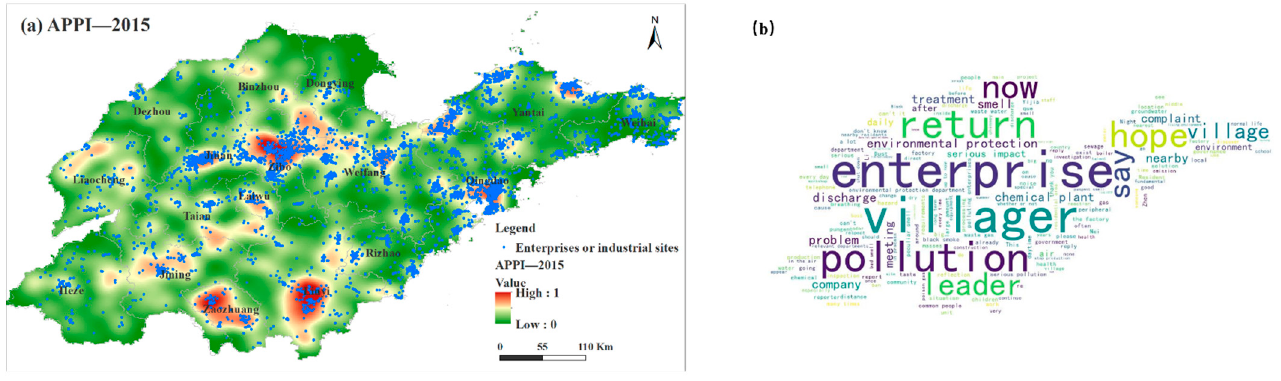
Figure 6. Superposition results of industrial sites and APPI in Shandong Province in 2015 ( a ) and content analysis of air pollution complaints based on word cloud ( b ).